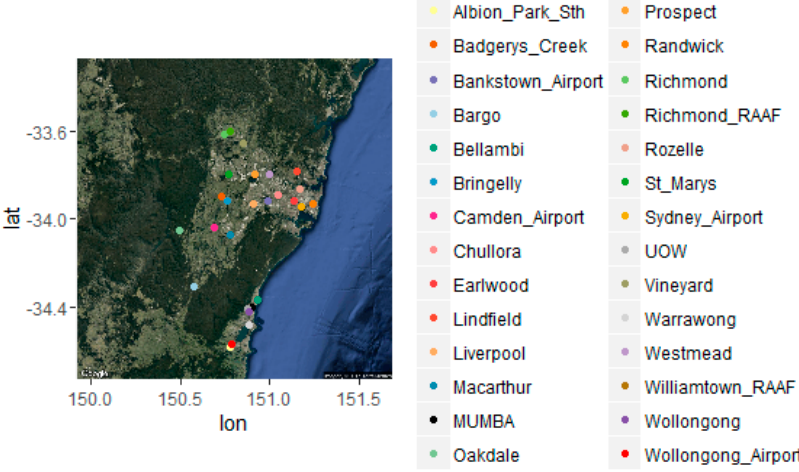
Figure 2. Meteorological air quality monitoring stations over the Greater Sydney (d04).